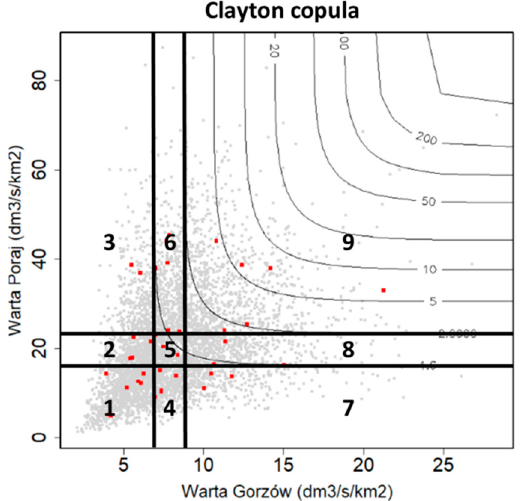
Figure 2. Example of combined accumulated curves of the probability of exceedance of the maximum specific runoffs and the determination of sectors (1–9) with their various degrees of synchronicity or asynchronicity.